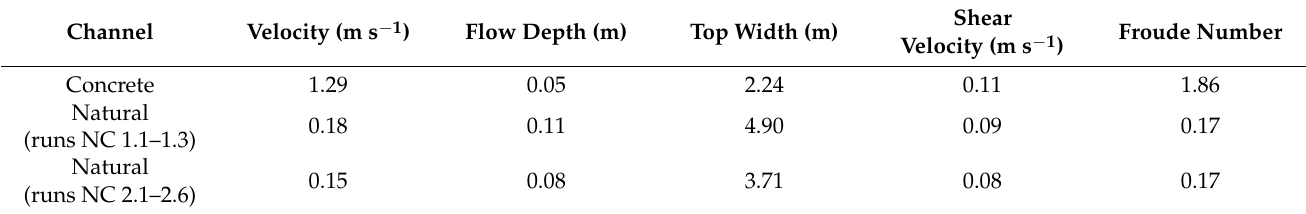
Table 1. Reach-averaged hydraulic characteristics of the study channels.